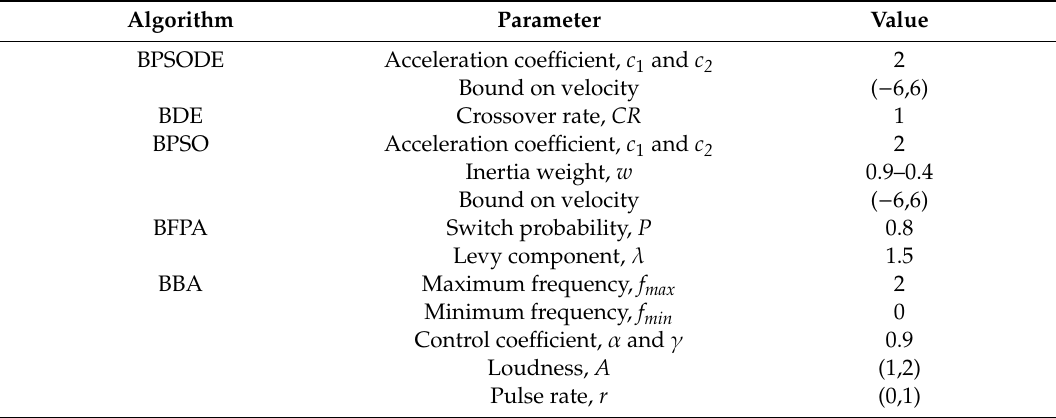
Table 1. Parameter settings of the hybrid binary particle swarm optimization di ff erential evolution (BPSODE), binary bat algorithm (BBA), binary di ff erential evolution (BDE), binary particle swarm optimization (BPSO) and binary flower pollination algorithm